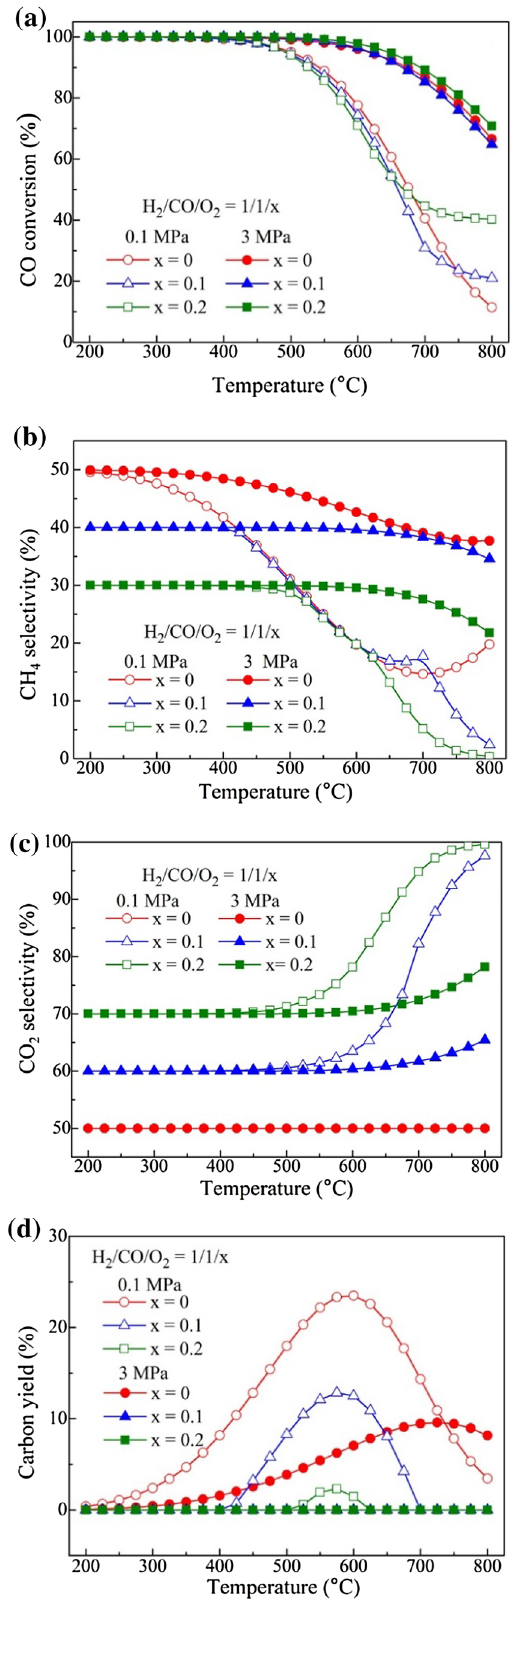
c Fig. 8 Effect of O